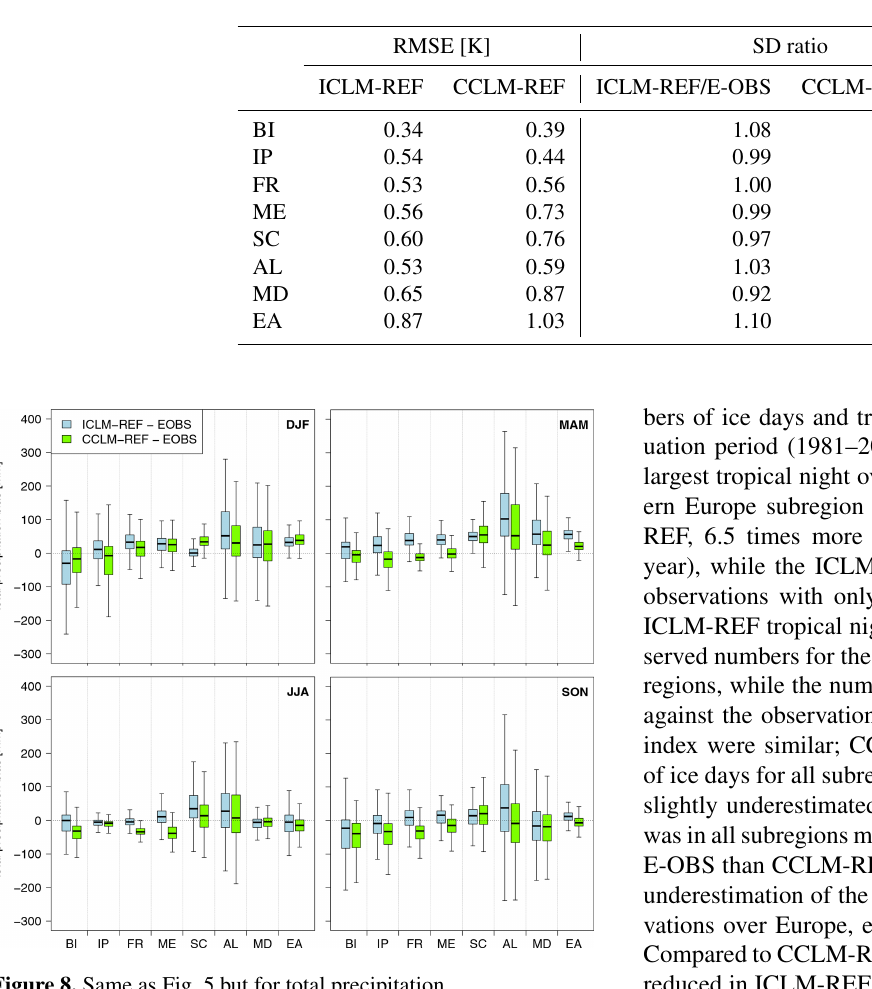
Table 4. RMSE and spatial SD ratio of averaged monthly 2m temperature for the PRUDENCE subregions. Data are from ICLM-REF, CCLM-REF and E-OBS from 1981 to 2000.